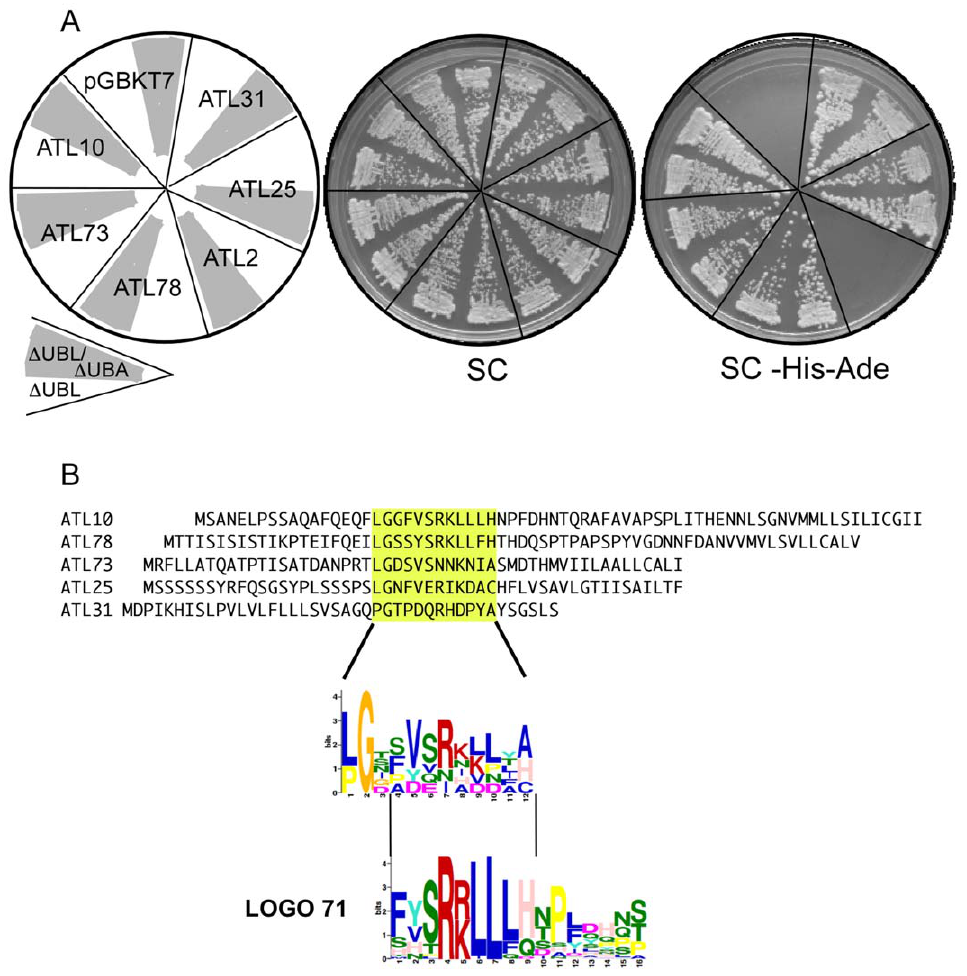
Figure 9. Interaction of DSK2a/ubiquilin with diverse ATLs. (A) Representative plates showing yeast two-hybrid interactions between DSK2a/ ubiquilin and region I from six ATL genes; the left panel shows the template of the plates. The 6 ATL-containing fragments were ligated into the DNA- binding domain of pGBKT7, the two DSK2a/ubiquilin clones, D UBL and D UBL D UBA (depicted in gray in the template plate), are as in Figure 8. The yeast two-hybrid assay was performed as in Figure 8. (B) A sequence LOGO in region I of ATLs. The MEME suite was used to generate sequence LOGOs from the 5 yeast two-hybrid clones shown in (A) and from the ATL2 clone. A sequence LOGO resulted from the region highlighted in yellow in the five clones; this region was not found in ATL2. As comparison, this sequence LOGO placed over the sequence LOGO 71 is shown